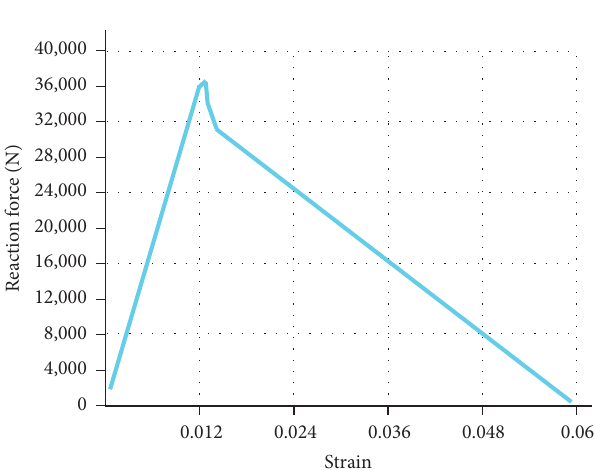
Figure 4: Reaction force versus strain relationship in simulated CFRP